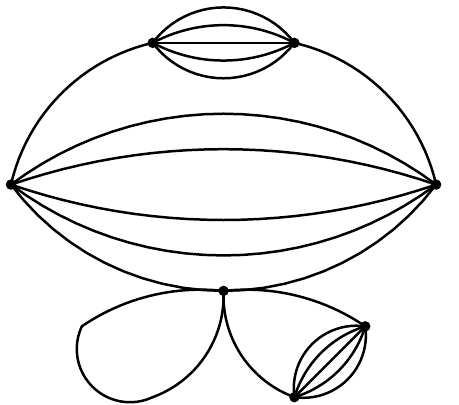
Figure 2. An example of melon-tadpole Feynman diagram. Double tadpoles are based on the I b ( b 2 [1 ; 5]) vertices and melons are based on I 1